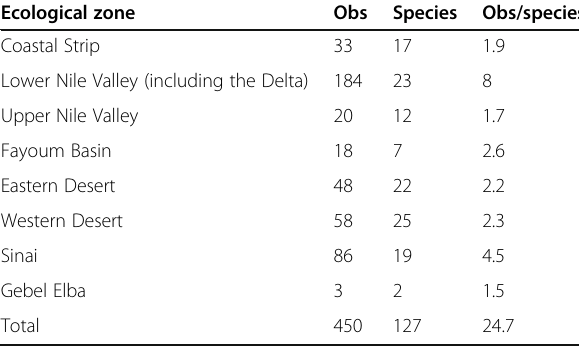
Table 2 Mantodea distribution by the ecological zone in Egypt. Number of observations (obs), species, and ratio of observations to